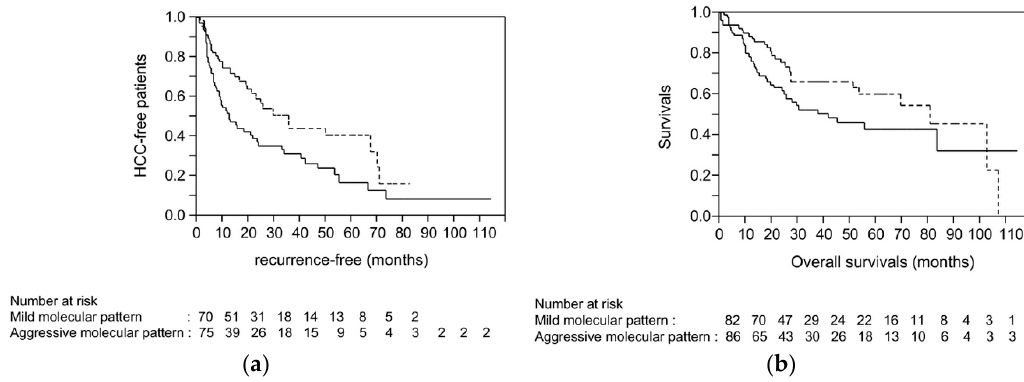
Figure 4. Recurrence-free survival ( a ) and overall survival ( b ) of HCC patients who underwent liver resection. The dataset included 376 HCCs referred from the Cancer Genome Atlas (TCGA). Among these, the results of whole exome sequencing, copy number values by Affymetrix SNP6, methylation